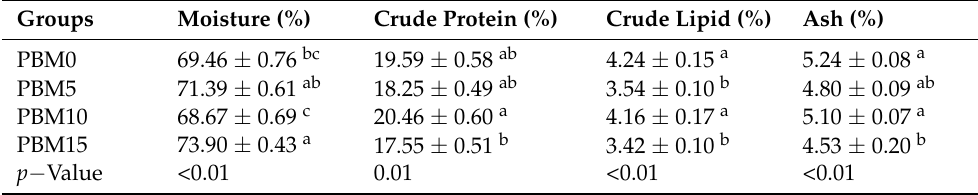
Table 2. Effect of dietary replacement of fish meal with poultry by-product meal on the whole-body proximate composition of Chinese soft-shelled turtle.